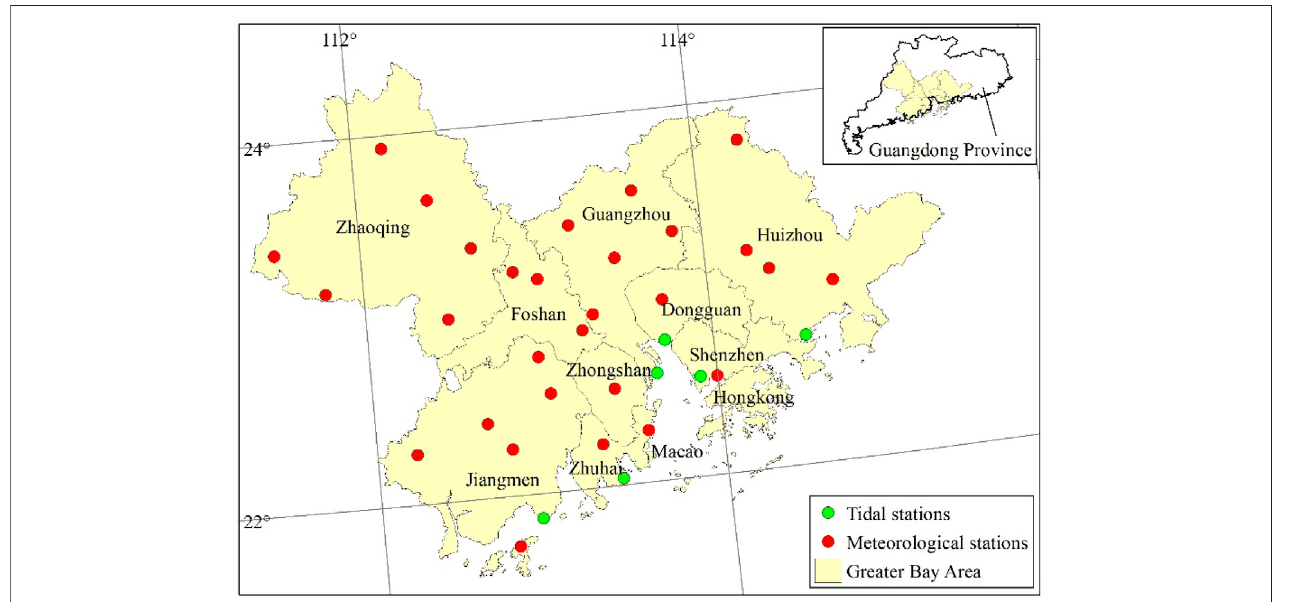
FIGURE 1 | Locations of the Guangdong – Hong Kong – Macau Greater Bay Area, meteorological stations, and tidal